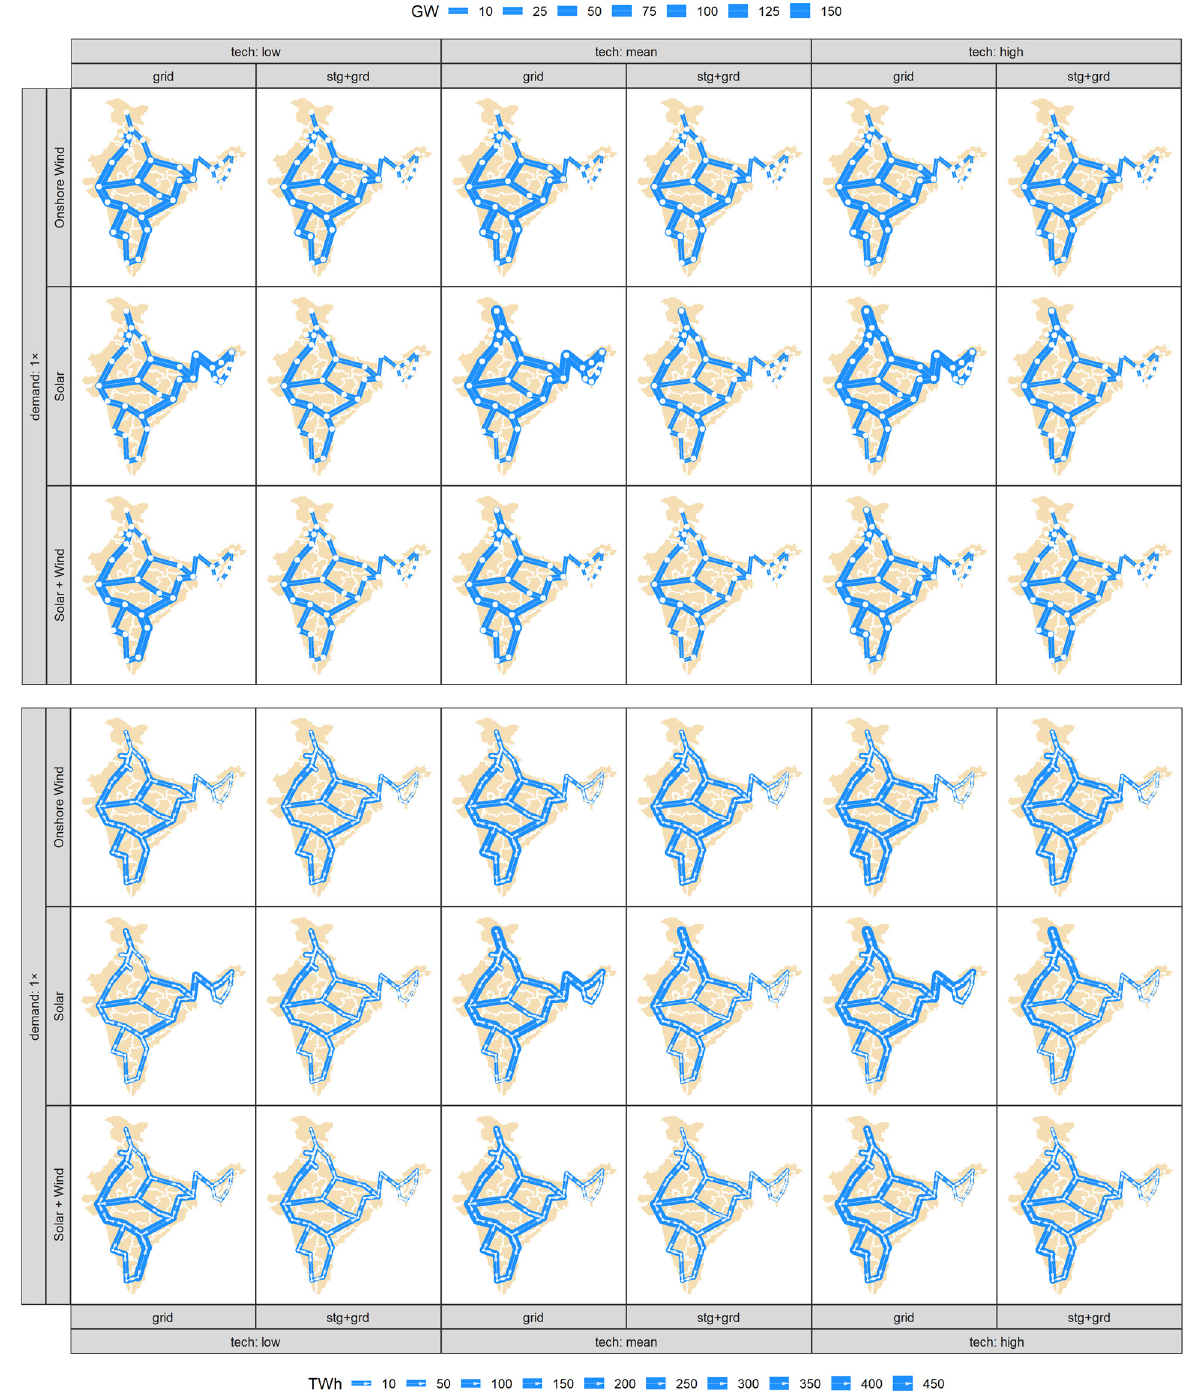
Figure A26. Interregional grid capacity and annual trades by scenario, demand level same as 2019.